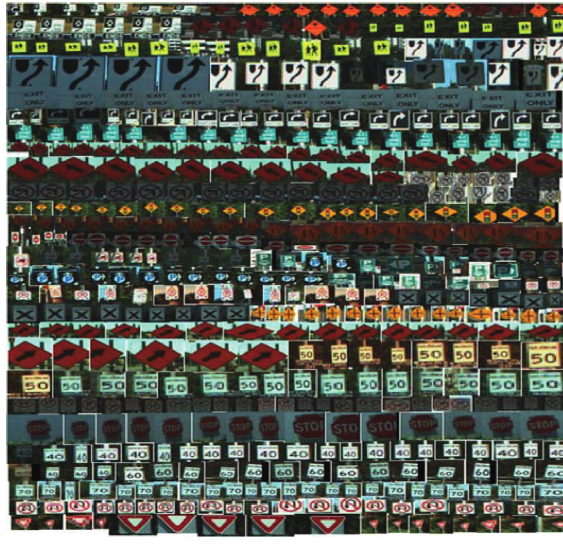
Figure 3: Examples of images of traffic signs used for